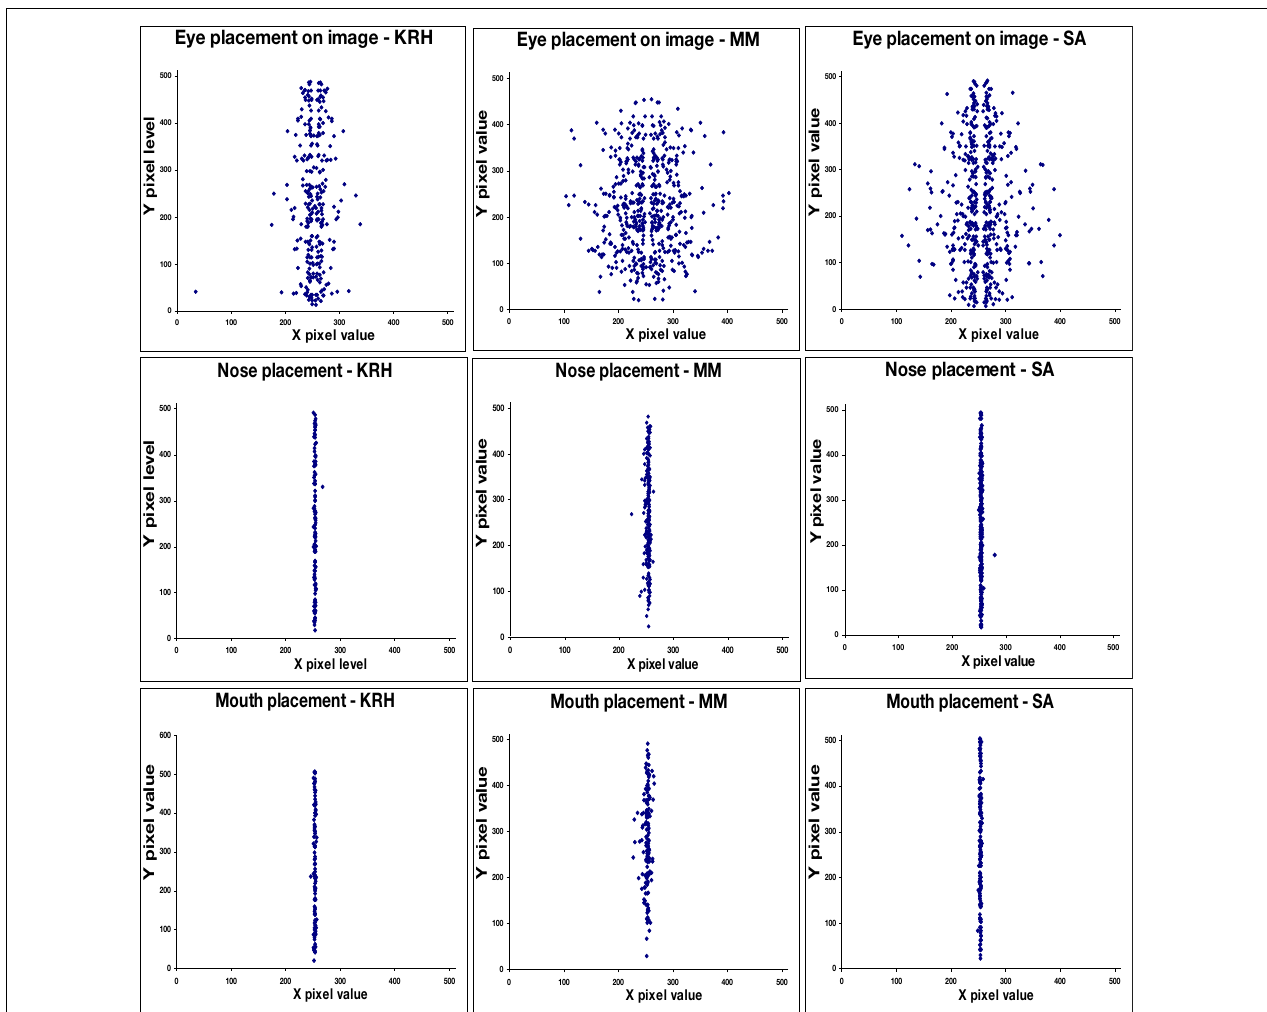
FIGURE 4 | Perceived locations (center pixel) of features in the images, illustrated for three observers. Top: eye positions; middle: nose positions; bottom: mouth positions.